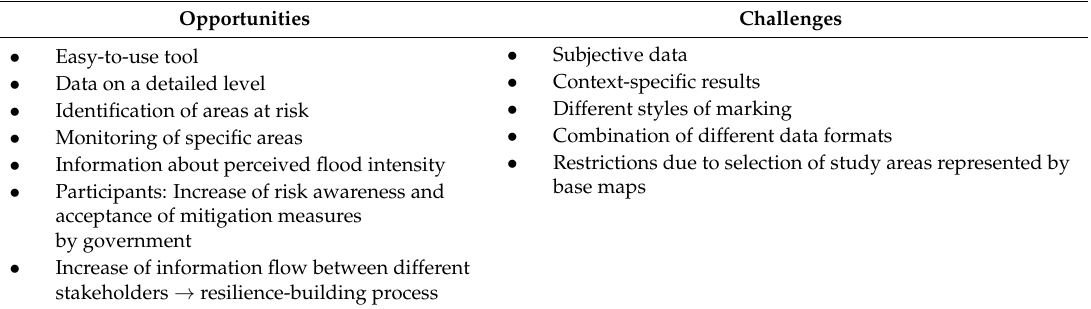
Table 3. Risk perception via sketch maps and questionnaires: key opportunities and